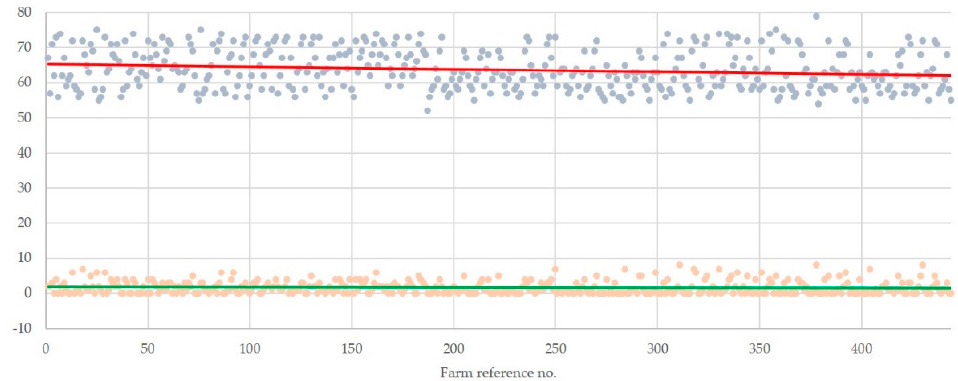
Figure 2. Plot diagram of the progressive duration of the interviews (fade blue spots) and clarifications asked by the farmers (fade orange spots), with slope lines: solid red line (slope: − 0.0075) and solid green line (slope: − 0.0006), respectively ( n = 444) (the vertical axis shows durations of interviews (min) and no. of clarifications asked by the farmers).